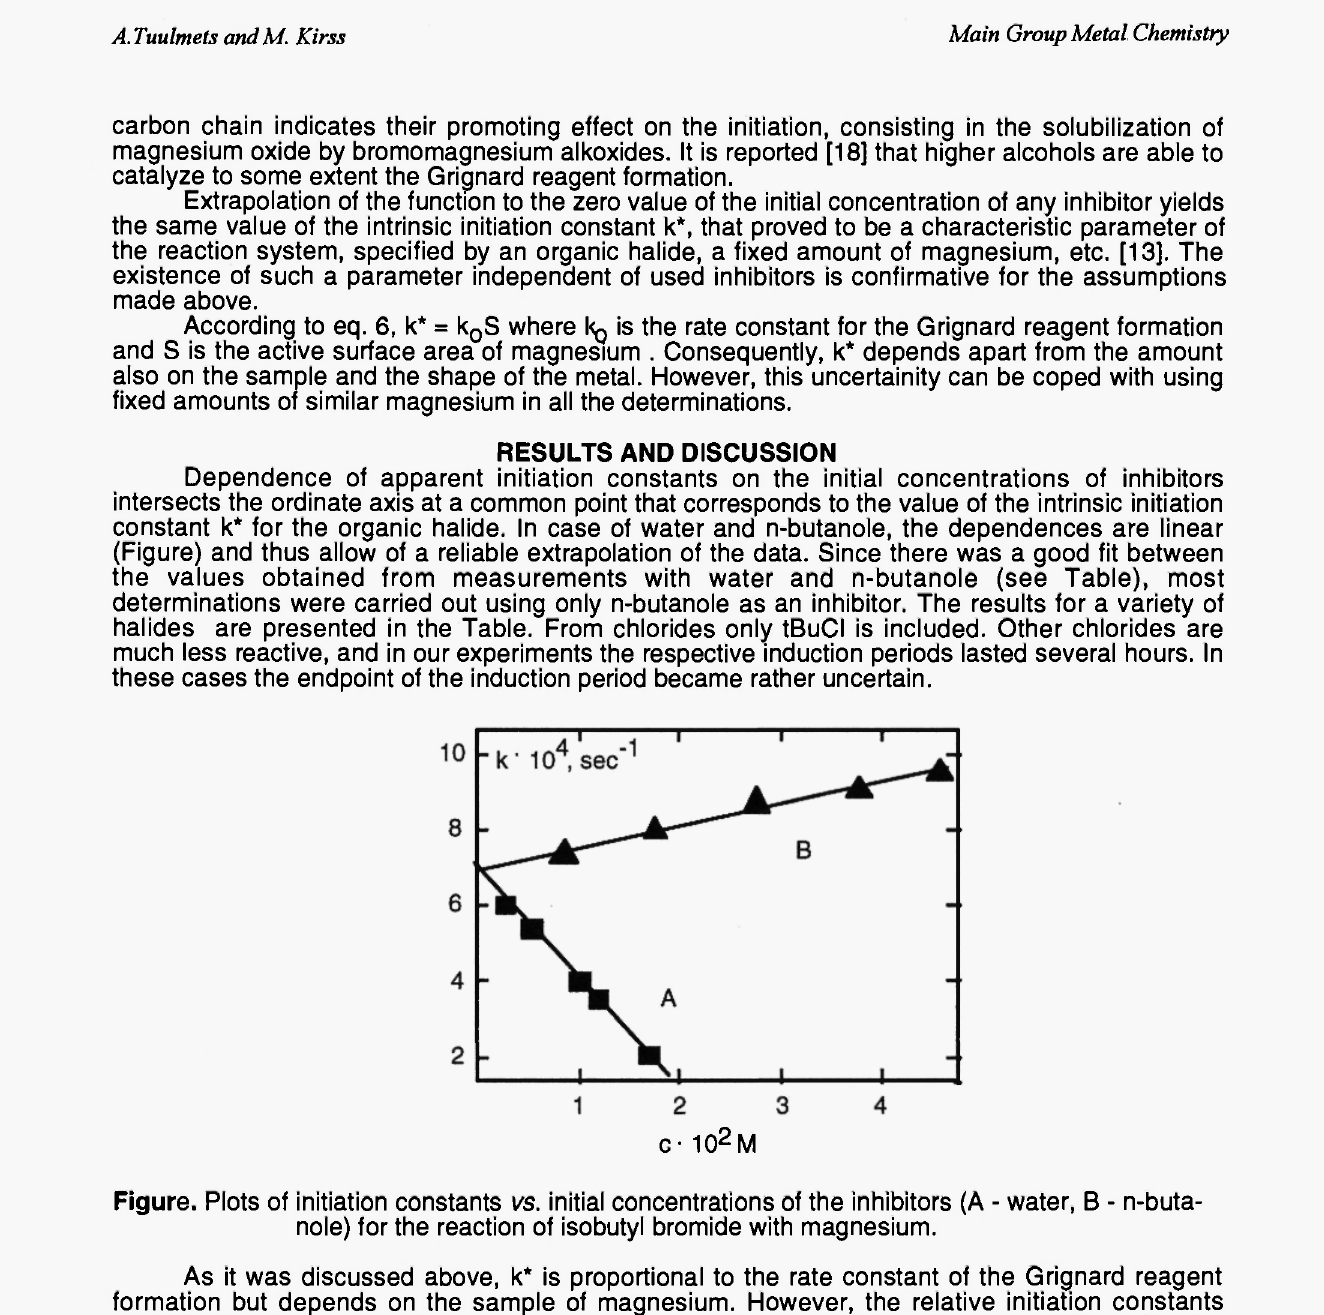
Figure. Plots of initiation constants vs. initial concentrations of the inhibitors (A - water, Β - n-buta- nole) for the reaction of isobutyl bromide with